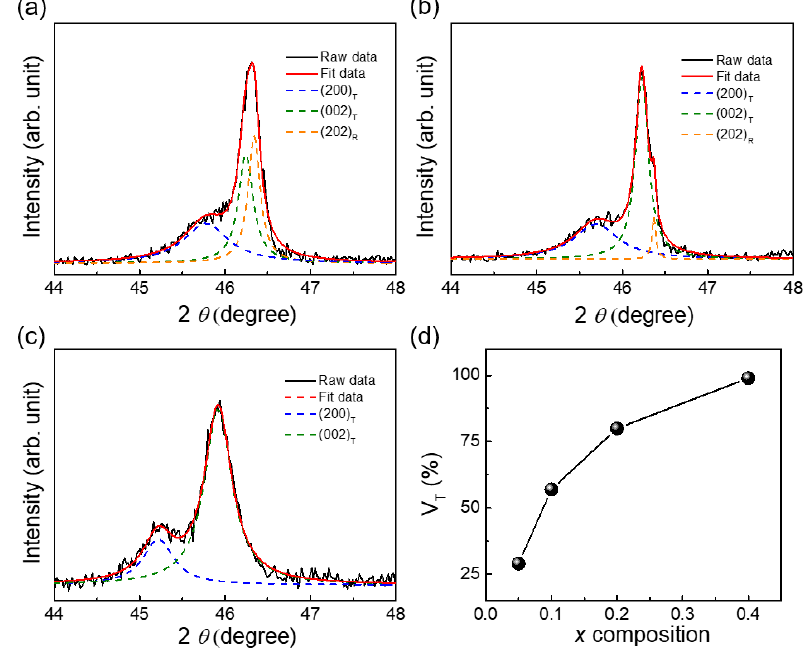
Figure 4. X-ray di ff raction patterns of BNKT ceramics, their fitting results for ( a ) x = 0.10, ( b ) x = 0.20, and ( c ) x = 0.40 in the BNKT ceramics in the 2 θ range of 44 ◦ to 48 ◦ to distinguish the rhombohedral and tetragonal phase; and ( d ) the percentage of tetragonal phase ( V T ) for the synthesized BNKT ceramics.